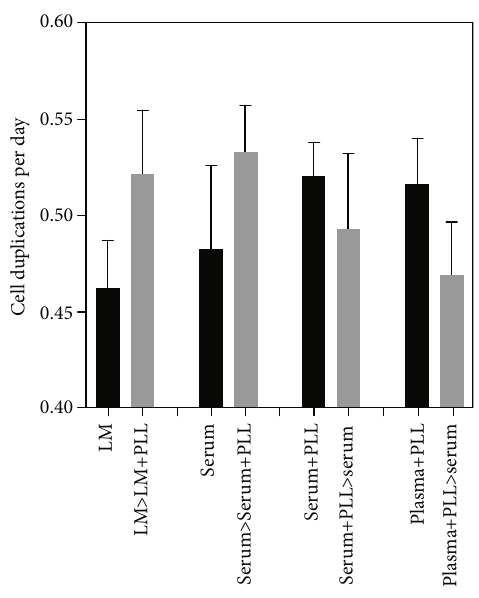
Figure 4: E ff ect of PLL on proliferation of pMSCs. The pMSCs from 5 donors were expanded either in LM, medium complemented by serum, serum+PLL, or plasma+PLL and further cultured for 2 consecutive passages in medium enriched (grey bars) with or deprived from PLL (black bars) as indicated. Addition of PLL to expansion media increased cell proliferation in both cases (left side), while PLL deprivation reduced proliferation in the other two cases (right